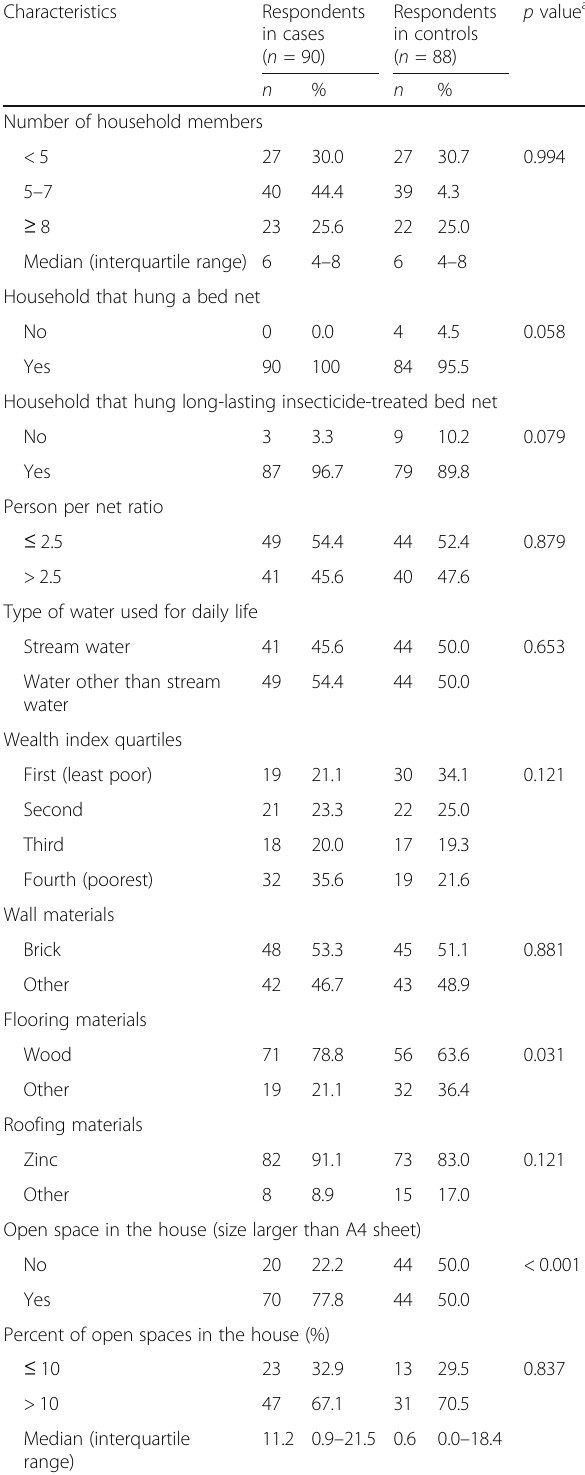
Table 4 Bivariate analysis of the associations between household-level characteristics